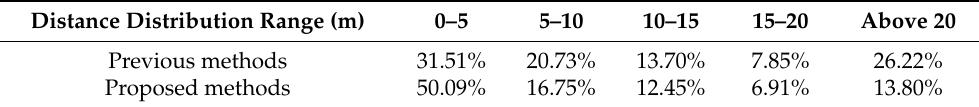
Table 5. Comparisons between previous method and the proposed Table 4. Proportion of distribution range of deviation distance.